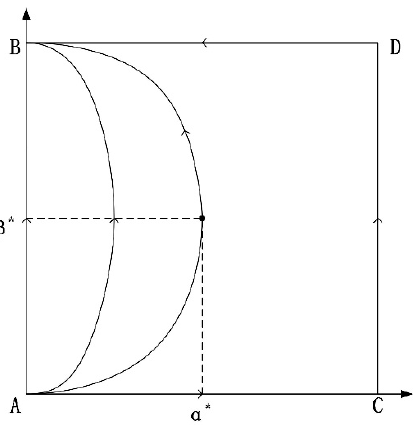
Figure 7. Scenario 2 evolutionary path between local government and the public.